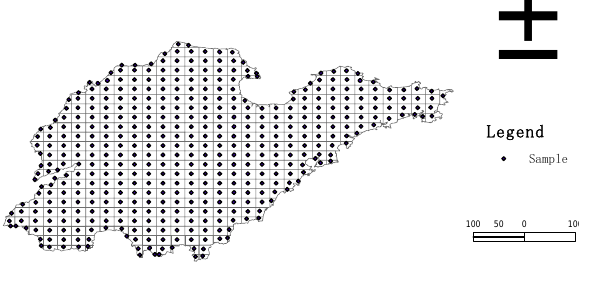
Figure 7. Cultivated land enumerate survey by aerial photos in Shandong (China) in year